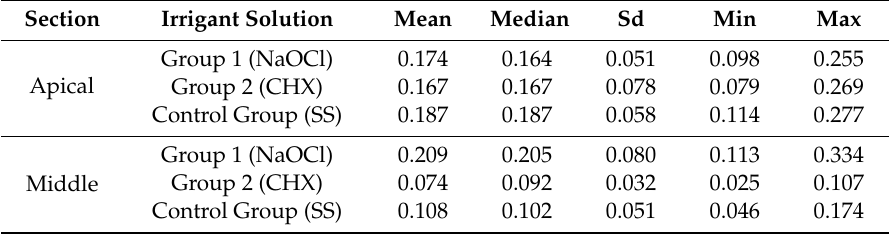
Table 1. Sealer penetration for the apical and middle section of the